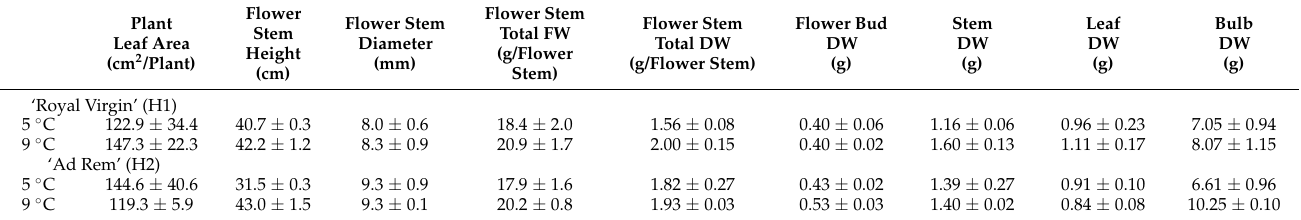
Table 1. Plant growth parameters, fresh and dry weight, and dry matter partitioning in the different organs in plants of the hybrids of Tulipa gesneriana L. ‘Royal Virgin’ and ‘Ad Rem’, grown hydroponi- cally from bulbs subjected to two preparation procedures, 5 ◦ C and 9 ◦ C. Mean values ± Standard error; n = 10.